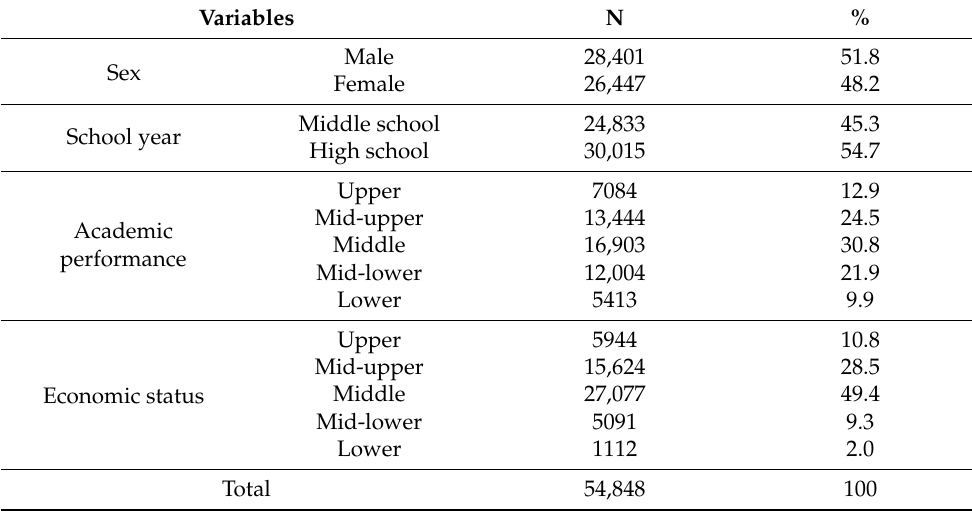
Table 1. Analysis of the characteristics of participants.